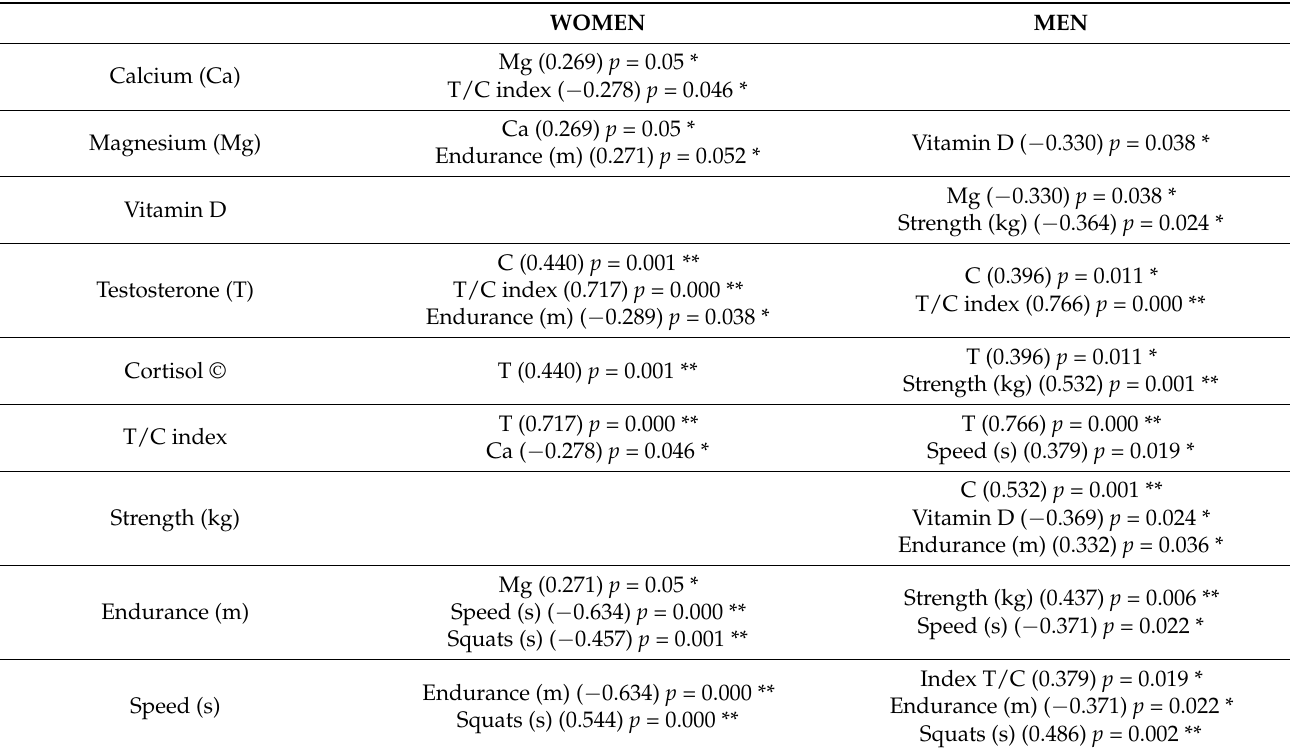
Table 3. Correlations between physical performance and calcium, magnesium and steroid hormones in the women and men that participated in the study.